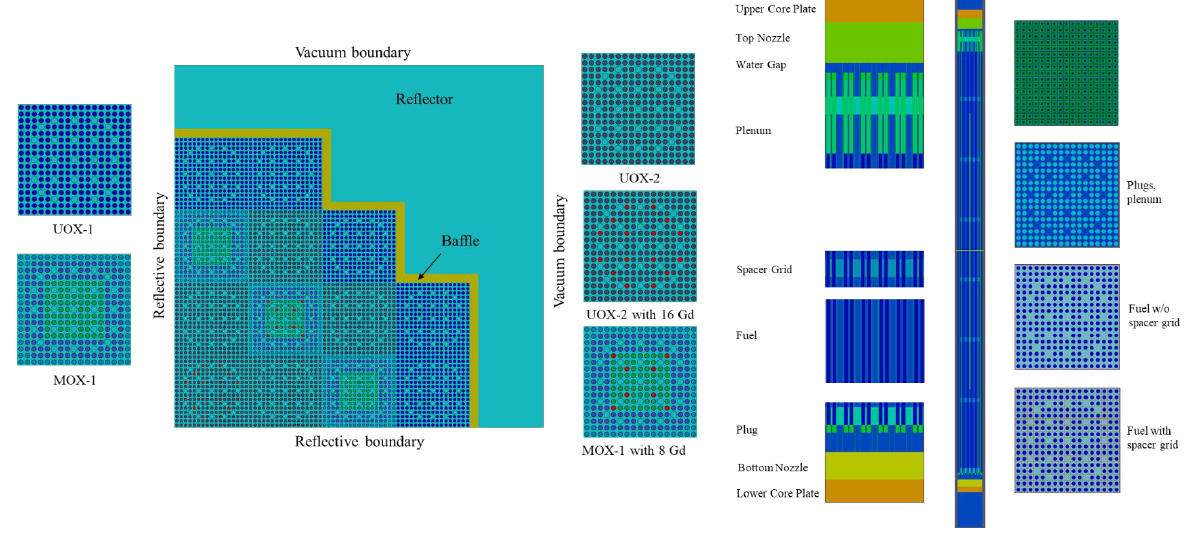
Figure 3. Specification of the KAIST core and VERA-3A assembly